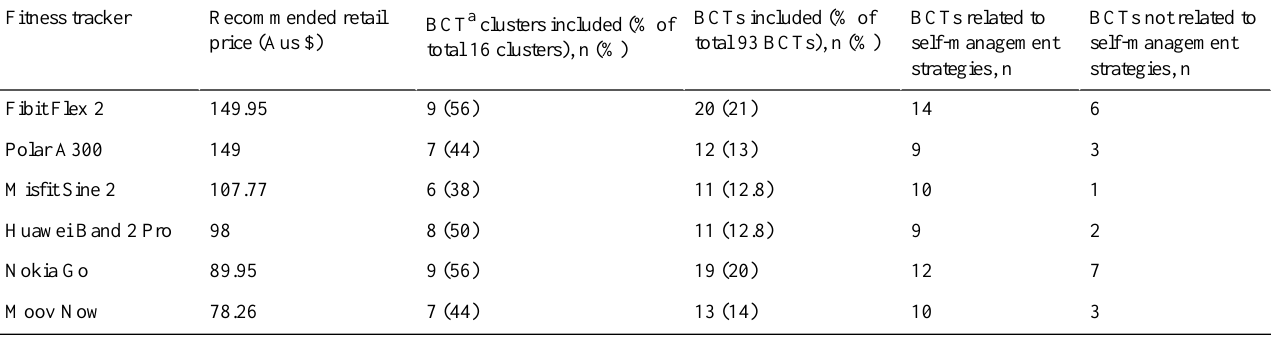
Table 1. Cost and the number of behavior change techniques incorporated in each fitness